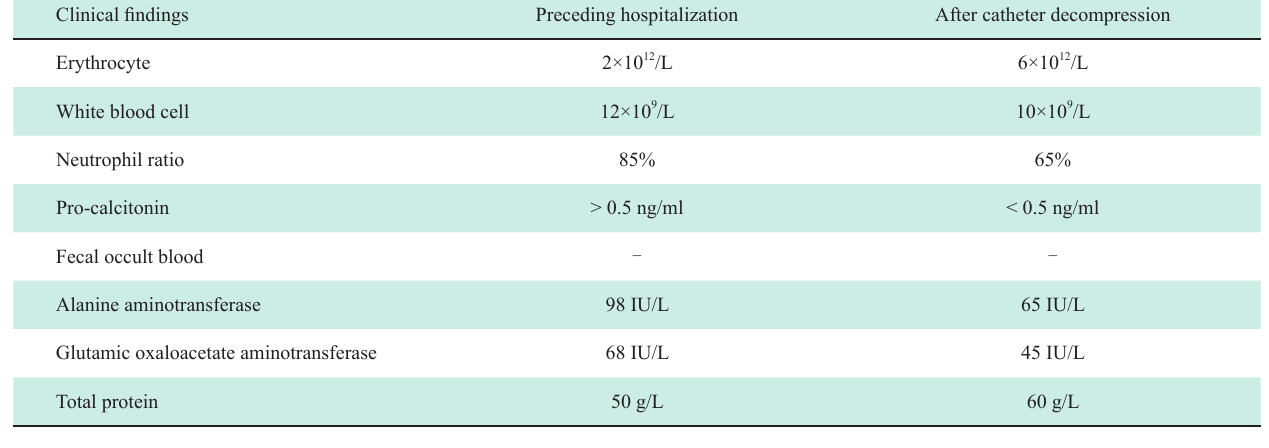
Table 1 Laboratory data at the preceding hospitalization and five days after catheter decompression Clinical findings